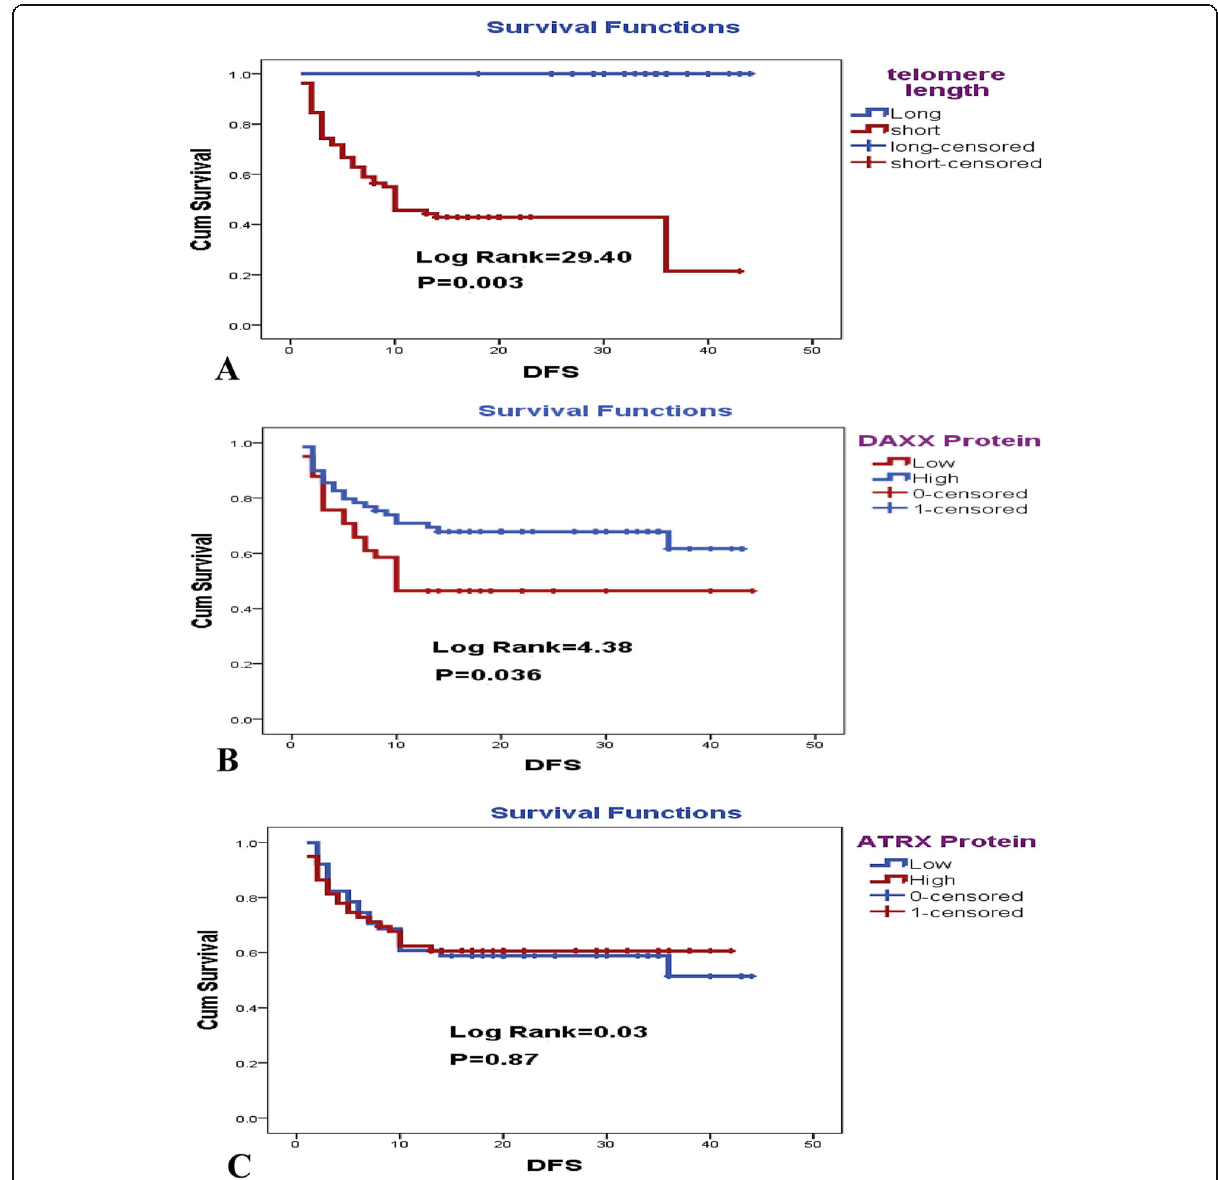
Fig. 3 DFS for telomere length, DAXX, and ATRX expression. a Telomere shortening is associated with poor DFS. b DAXX low expression showed significant bad impact on DFS. c ATRX low expression did not show significant impact in